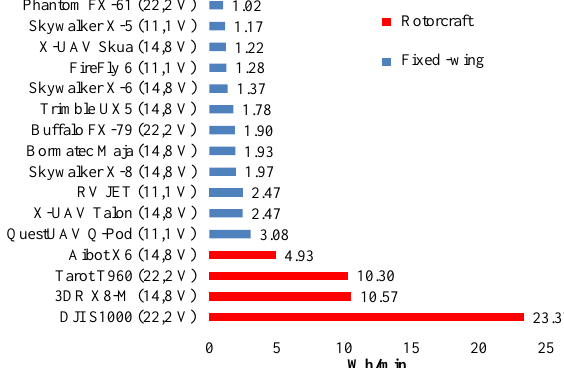
Figure 3 Energy required for 1 minute of flight. Adapted from (Trojanek,